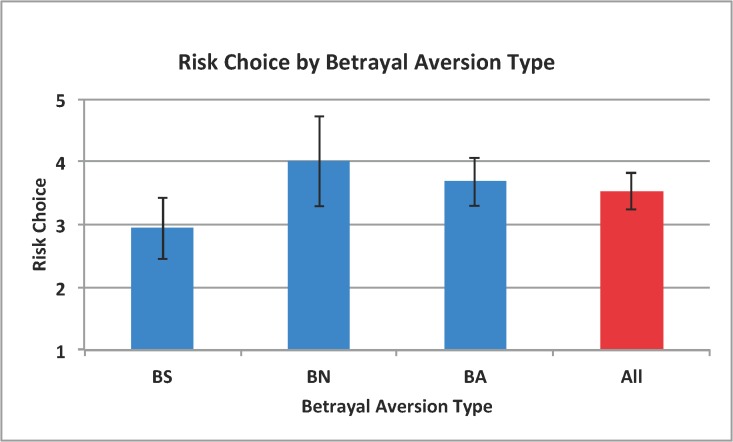
Bars reflect average risk choice (and standard error) by betrayal aversion type.Betrayal Seekers (BS) are those participants who required a premium to take the risk when nature chose the outcome (MAPti < MAPri). Betrayal Averse (BA) participants are those who required a premium to trust when their trustee chose the outcome (MAPti > MAPri). Betrayal Neutral (BN) participants are those who reported identical willingness to take risk whether nature or a trustee chose the outcome (MAPti = MAPri).